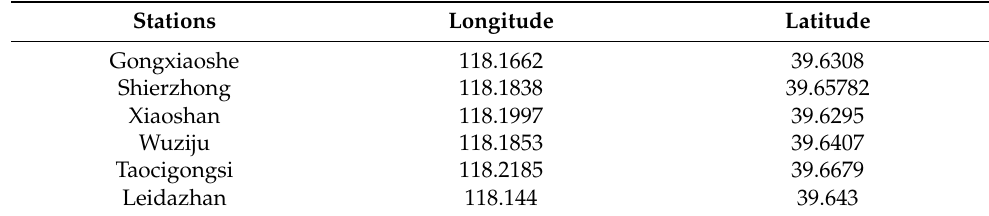
Table 1. Geographical coordinates of EPB environmental monitoring